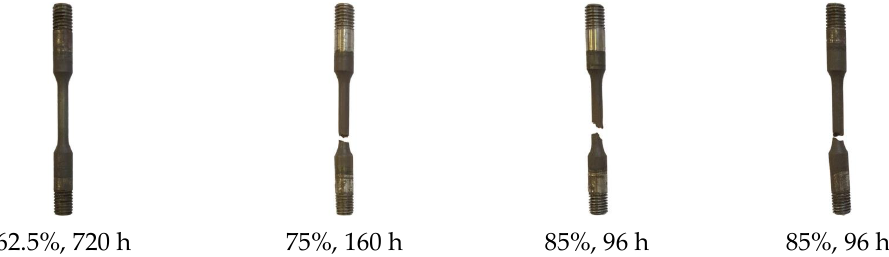
Figure 1. Samples after sulfide stress cracking (SSC)